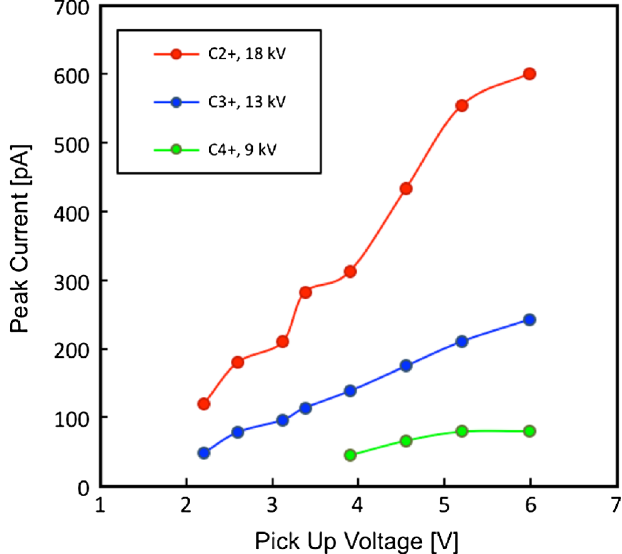
FIG. 36. Peak output current and the pulse arrival time on channel 1 as a function of the pickup voltage (plasma input position: 6 mm; extraction voltage: 30 kV).